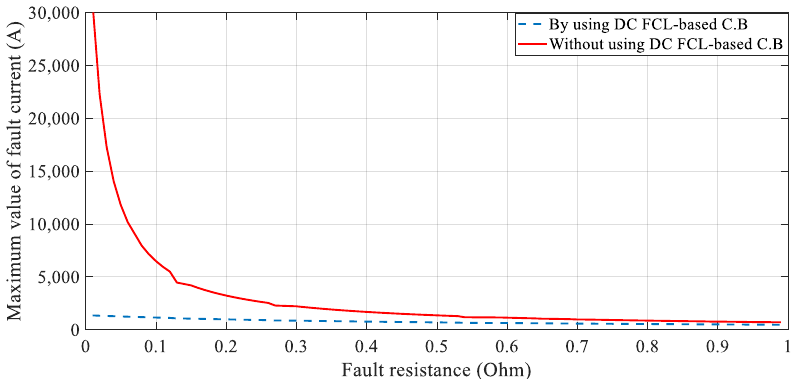
Figure 11. Performance of proposed DC FCL-based CB on the fault current.